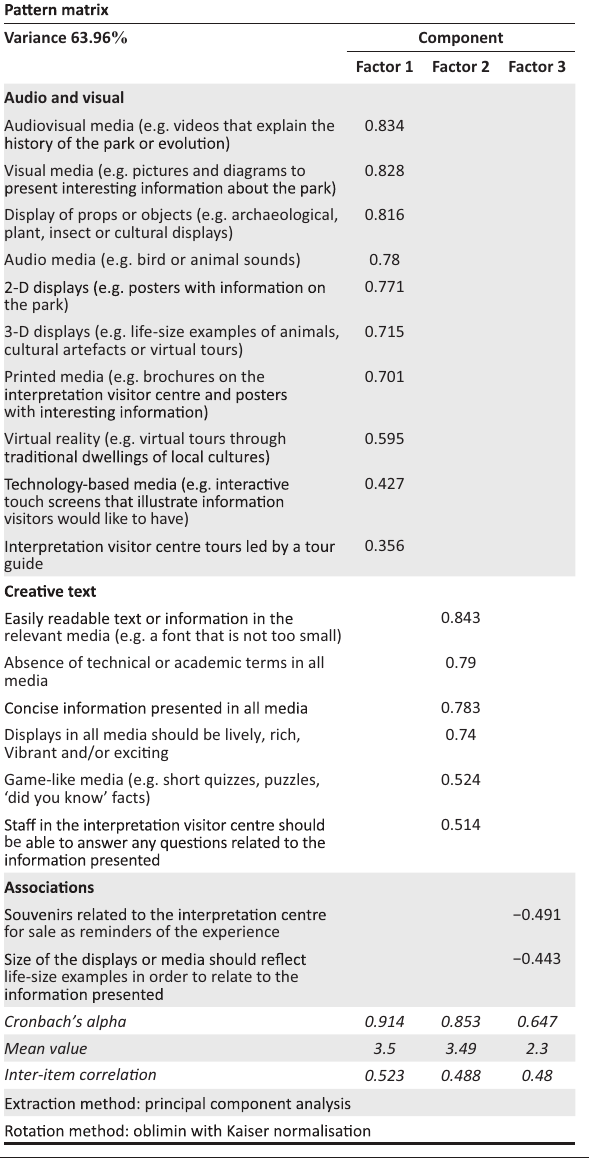
FIGURE 4: Important media needed for interpretation in the visitor centre at Kgalagadi Transfrontier Park (interpretation centre).